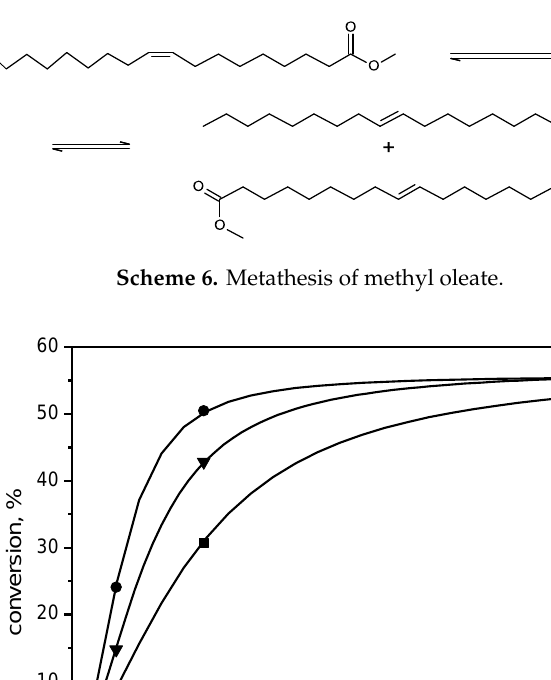
Figure 5. RCM of N,N-diallyl-2,2,2-trifluoroacetamide (DAF) with catalysts 4.8 (  ), 4.8 /SBA-15 (  ), 4.8 /MCM-48 (  ), 4.8 /SBA-16 (  ), and 4.8 /MCM-41 (  ). 30 ◦C, Ru/DAF = 1:100, toluene, c 0 (DAF) =